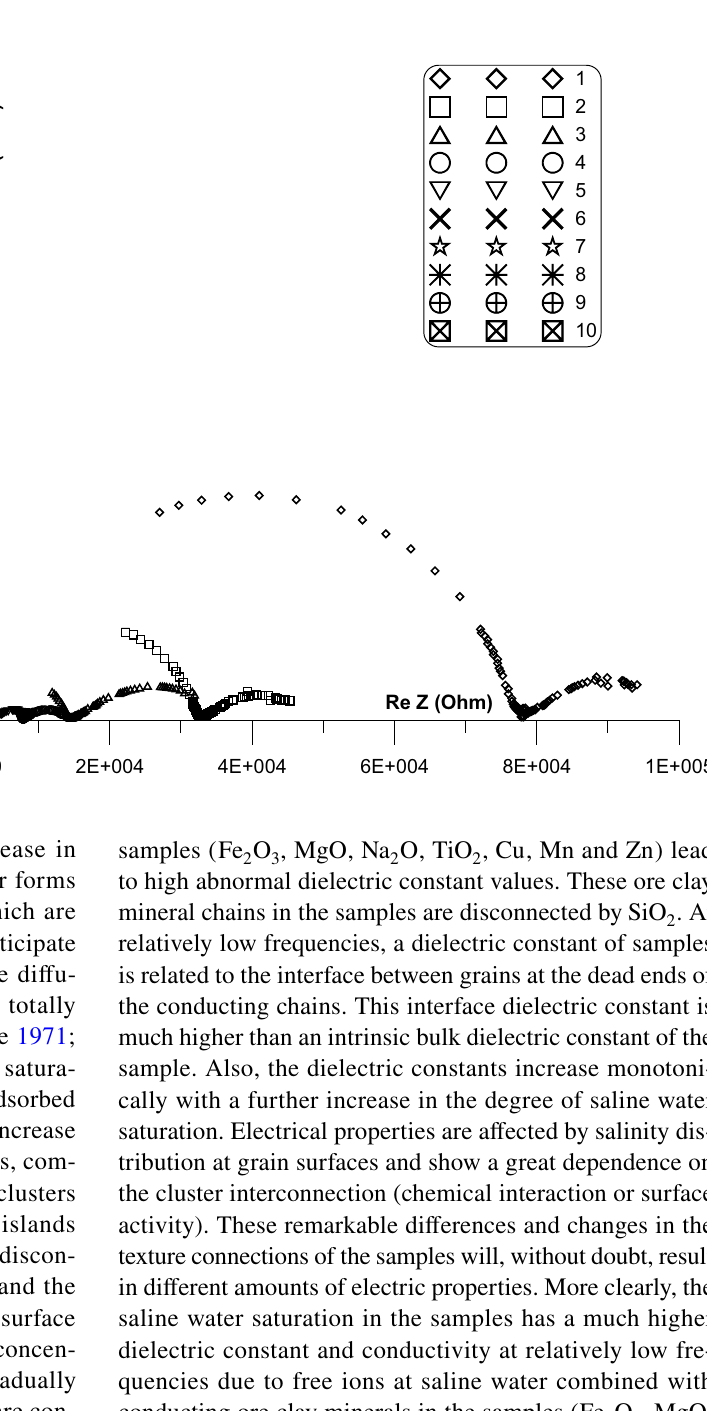
Fig. 3 Variation of complex resistivity plane as a function of frequency at different saturation levels of saline water (4 g/100 g of NaCl) [(1) diamond, (2) square, (3) triangle, (4) circle, (5) inverted triangle, (6) times symbol, (7) star symbol, (8) asterisk, (9) oplus symbol, (10) open square with times